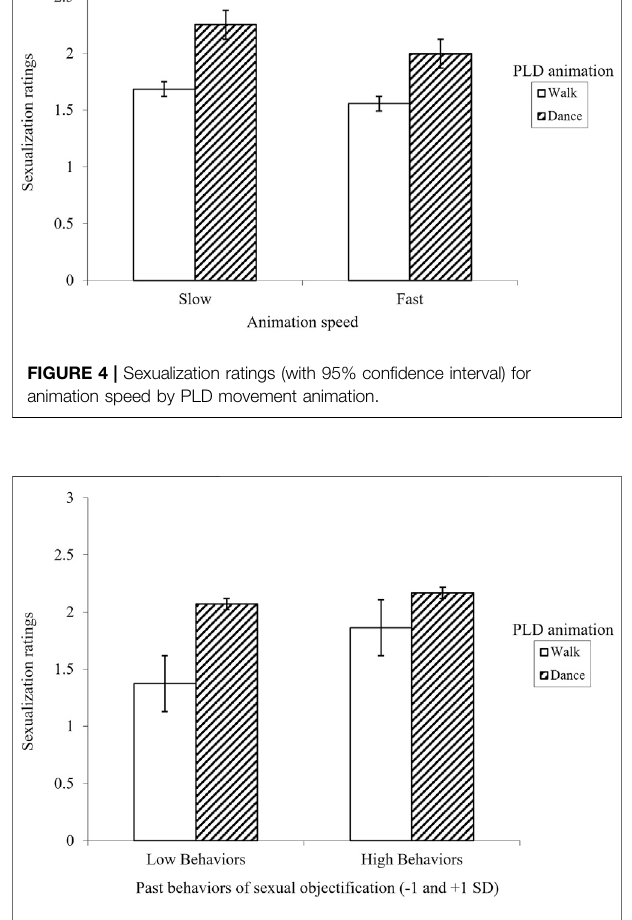
TABLE 5 | Mixed linear model for predicting perceived sexualization by conditions and past behaviors of sexual objecti fi cation. Predictors